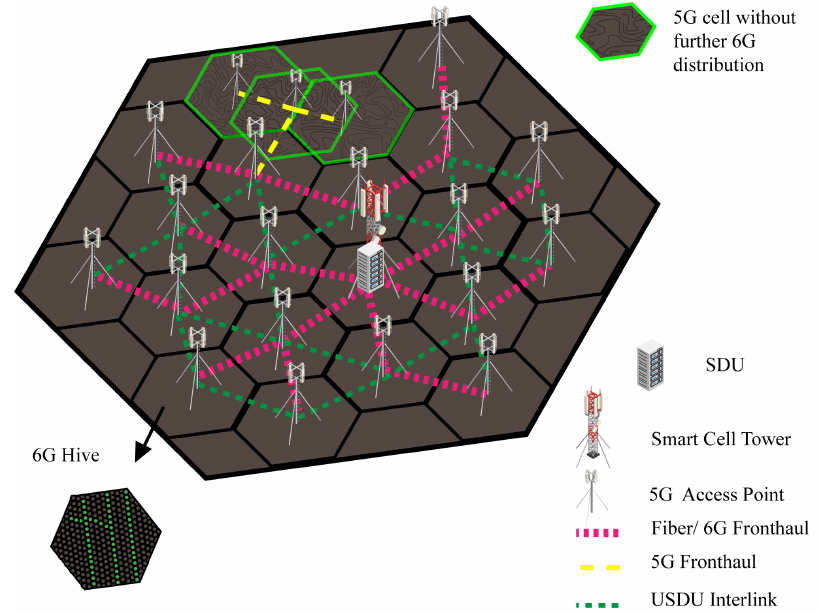
Figure 5. 5G cells hive.